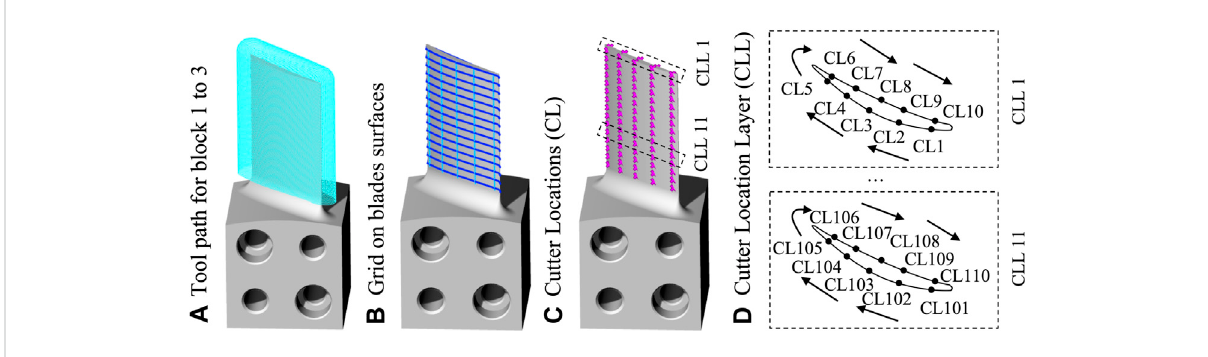
FIGURE 5 Procedure for selection of cutter locations used for subsequent FE modal analysis. (A) Toolpath for block 1 to 3, (B) Grid on blade surfaces, (C) Cutter Locations (CLs), (D) Cutter Location Layer